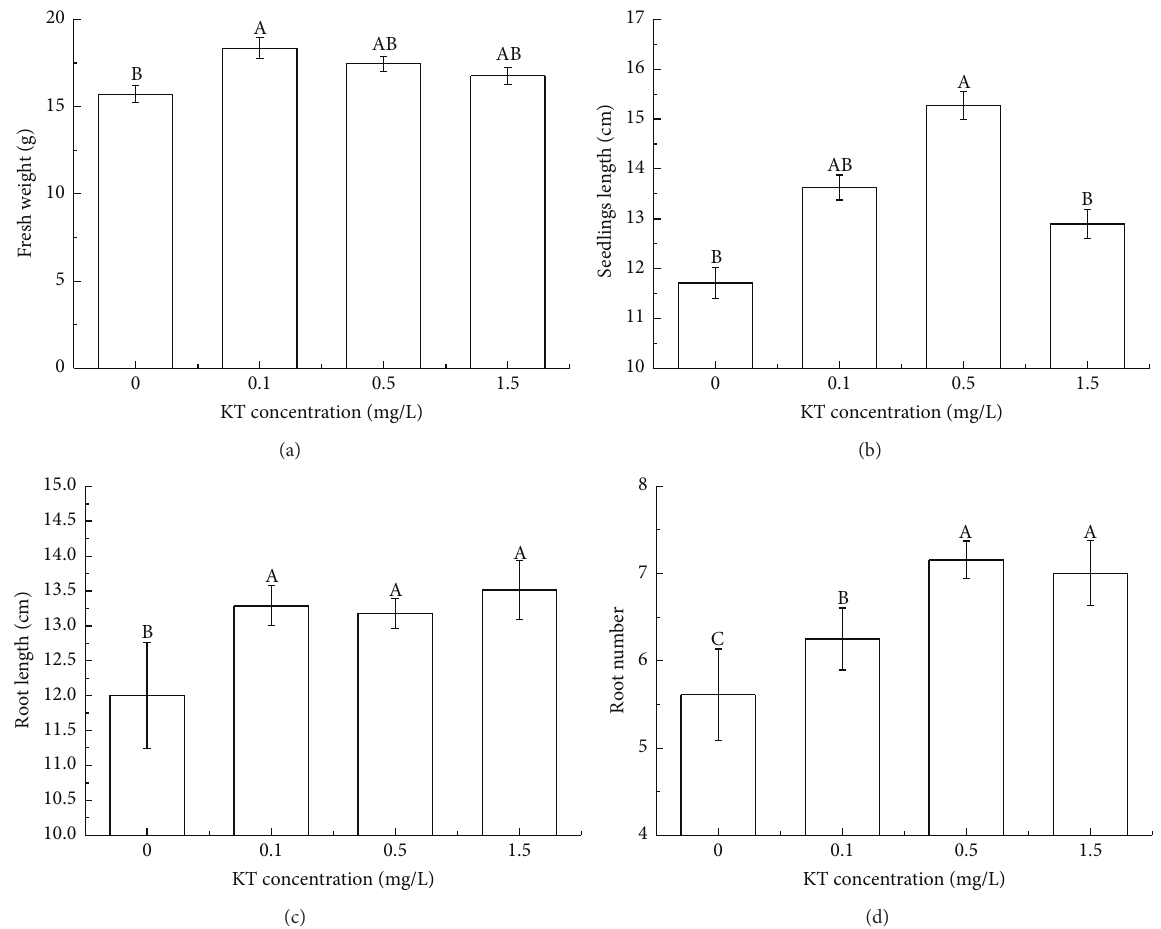
Figure 1: Effects of different concentrations of KT on the growth parameters of maize seedlings under 0.5 mg/L arsenic stress. Values with different letters indicate a significant difference ( 𝑃 < 0.05